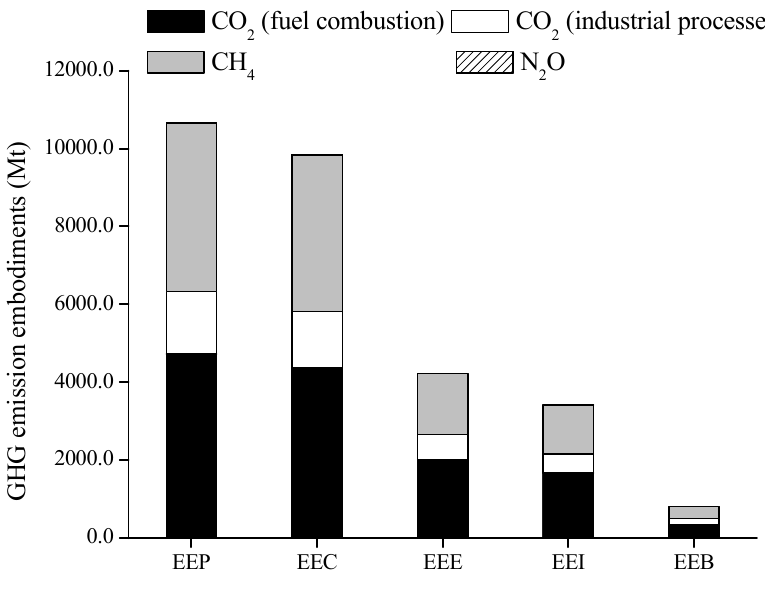
Figure 6. GHG emissions embodied in production, consumption and international